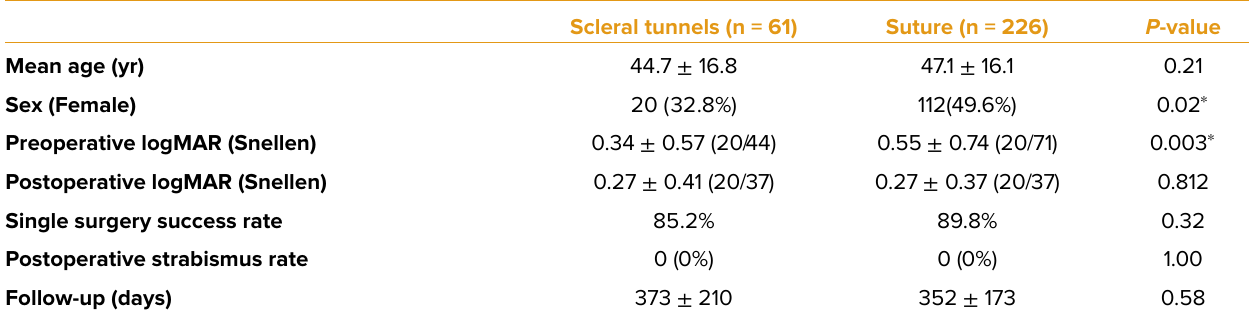
Table 3. Demographics and visual and anatomic outcomes comparing scleral tunnels versus scleral sutures in fixation of a scleral buckle during retinal detachment surgery in only eyes undergoing scleral buckling